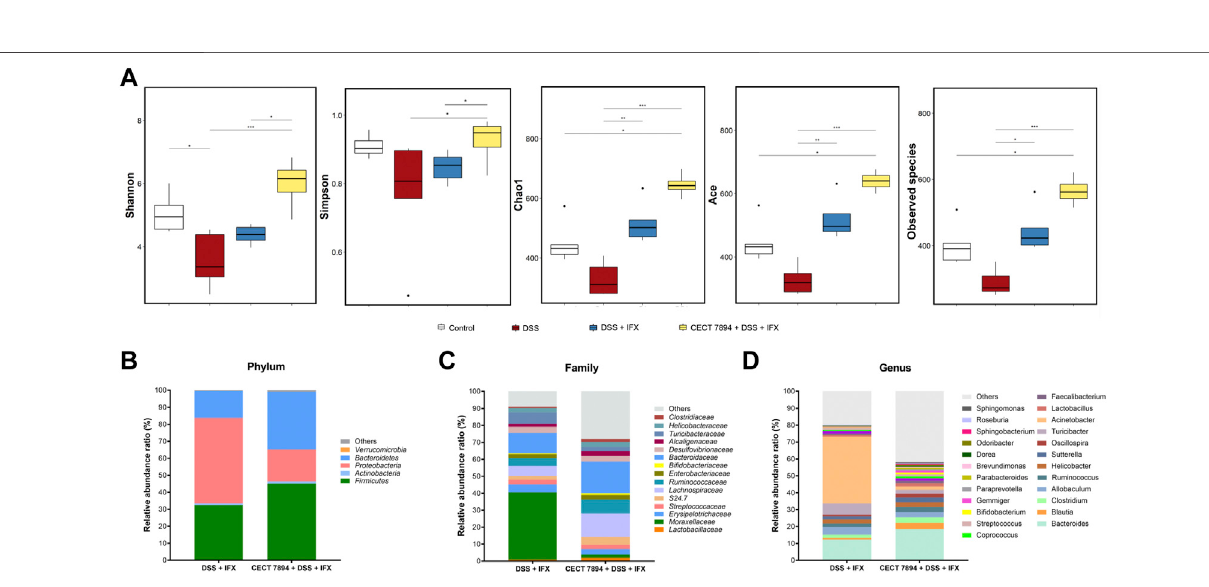
Frontiers in Pharmacology |